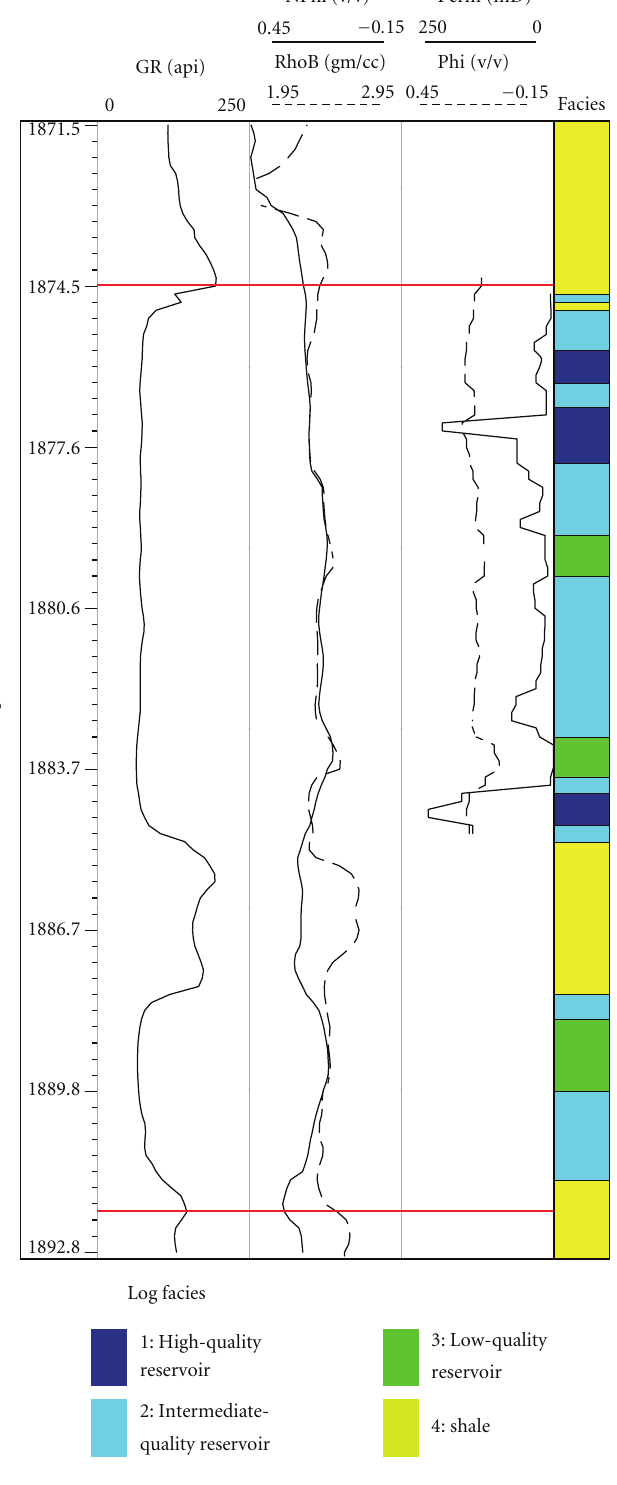
Figure 13: Log facies model applied to a well with core-measured porosity and permeability. The first track shows the gamma ray log. Track 2 plots the neutron porosity and bulk density. Track 3 represents core-measured permeability and porosity. The reservoir zone (Morrow A sandstone) is shown between the horizontal red